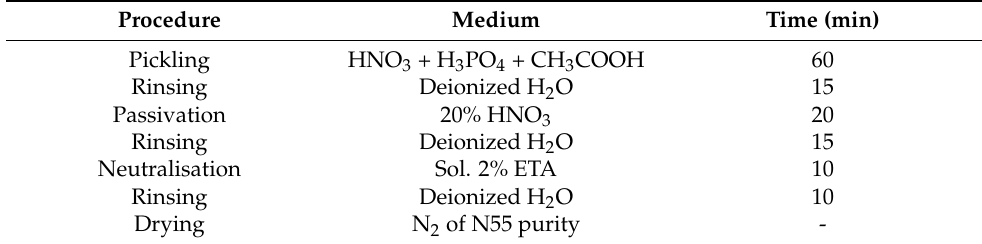
Table 3. The operating procedure for pickling and passivation of the hypotubes.